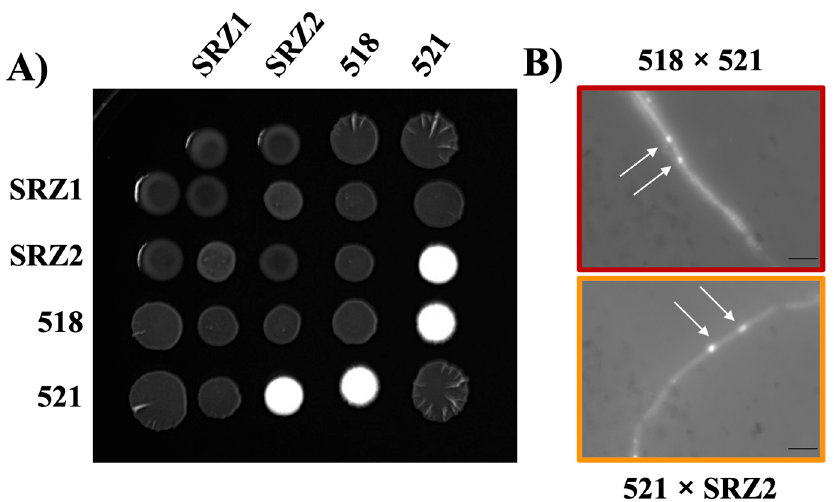
Figure 1. Dikaryon formation by 521 and SRZ2. The indicated mixtures of compatible haploid strains were spotted onto PDA + charcoal plates and incubated for three days. ( A ) Co-spotting of indicated haploid strains. White fuzz indicated the formation of filaments ( B ) DAPI stained filaments of 518 × 521 and 521 × SRZ2 revealed the presence of two nuclei, indicated by the arrows. Scale bar, 2 μ m.